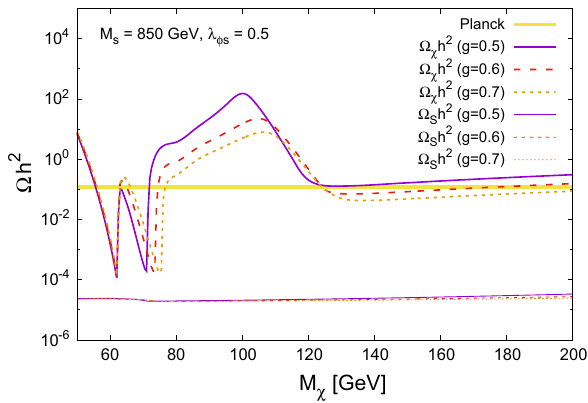
Fig. 1 Relic density as a function of fermionic DM mass for different values of the coupling g